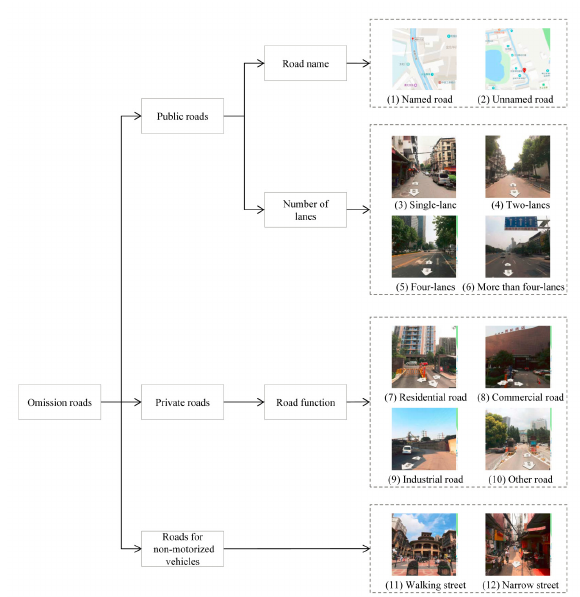
Figure 4. A hierarchical classification of omission roads